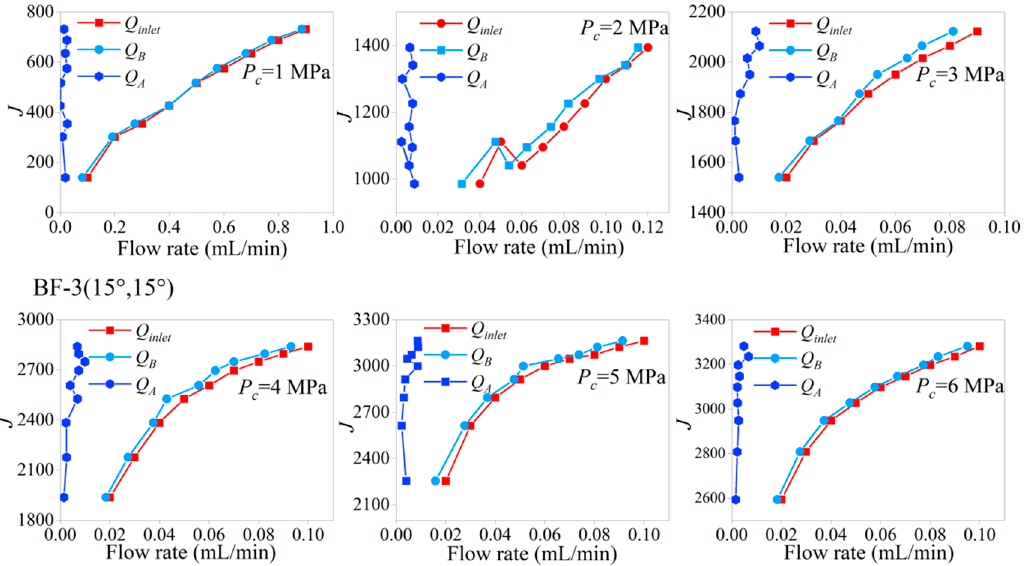
Figure 5. Curve change of flow rate and hydraulic slope in fracture seepage experiments.